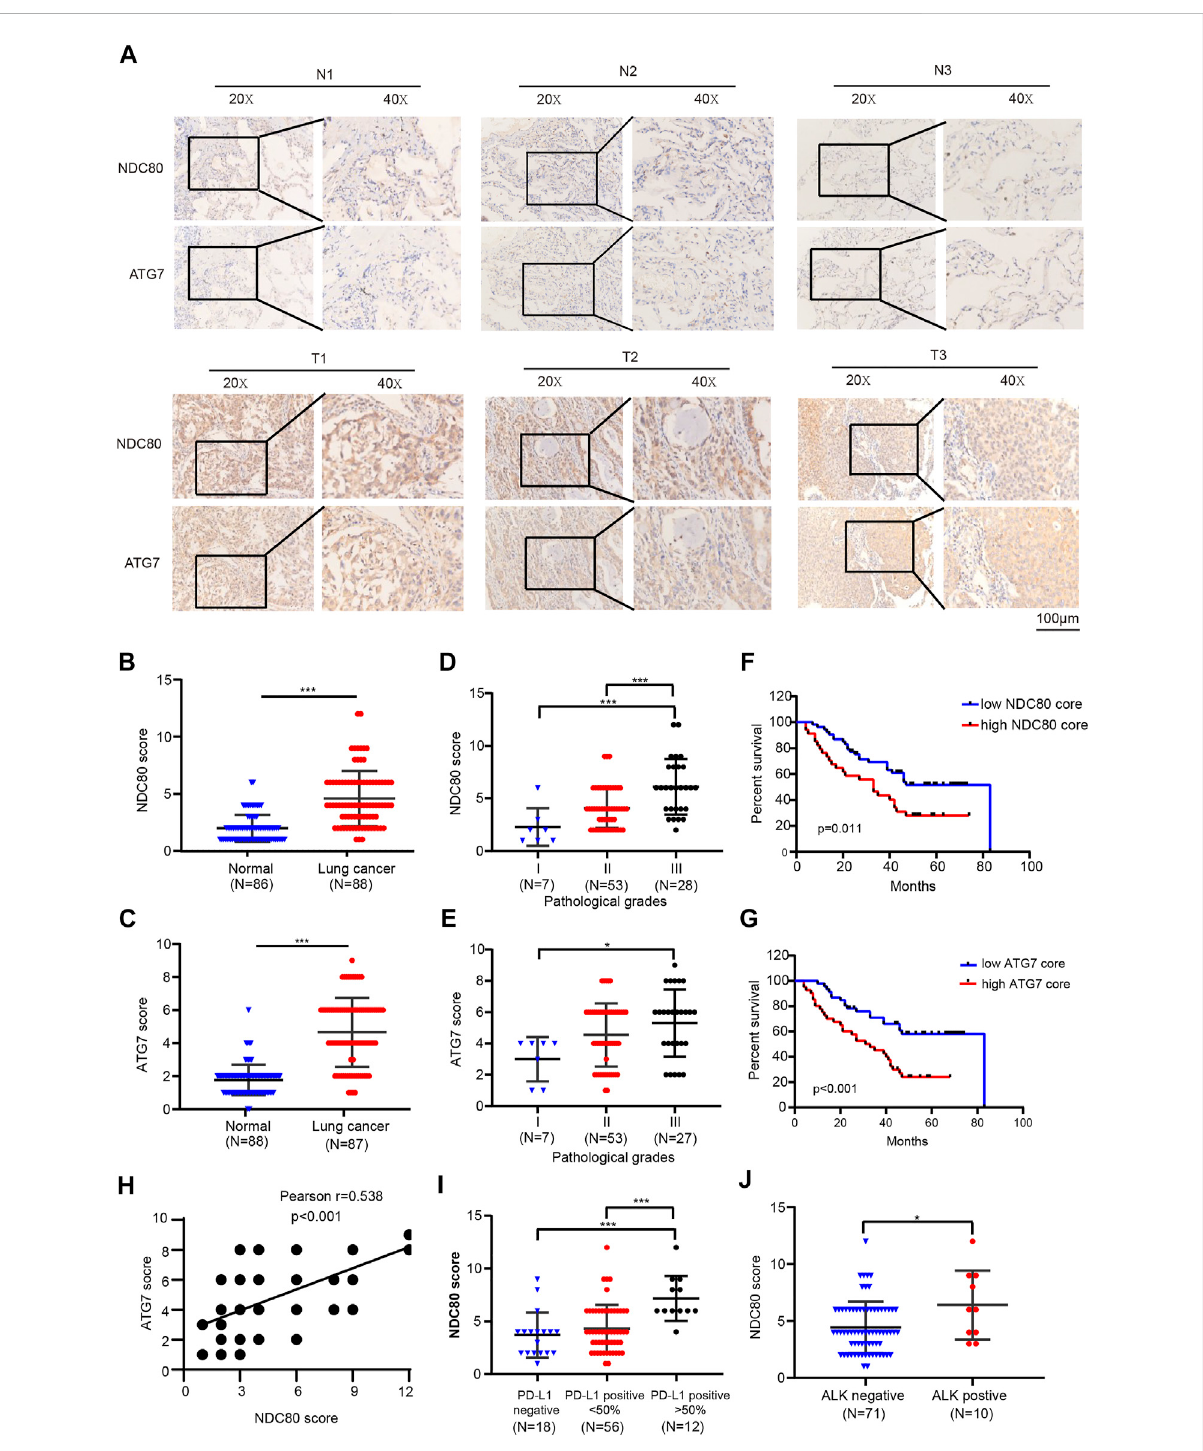
FIGURE 6 Identi fi cation of the correlation between the expression of NDC80 and ATG7 by IHC. (A – C) Determination of the expression levels of NDC80 and ATG7 in LUAD and healthy lung specimens by IHC analysis. (D,E) The comparison of NDC80 (D) and ATG7(E) expression in pathological stages. (F,G) The OS analysis of high- and low-expression levels of NDC80 (F) and ATG7(G). (H) The correlation between the expression of NDC80 and ATG7. (I,J) The correlation of NDC80 with PD-L1 expression (I) and ALK status (J) . * p < 0.05; *** p <